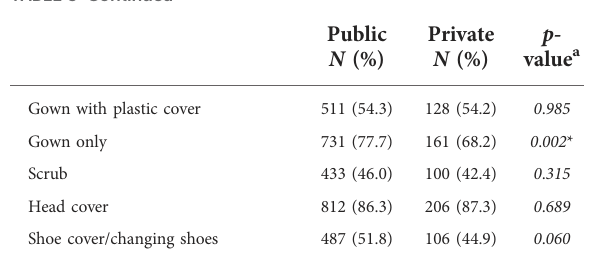
TABLE 3 Practice following infection control guidelines ( N